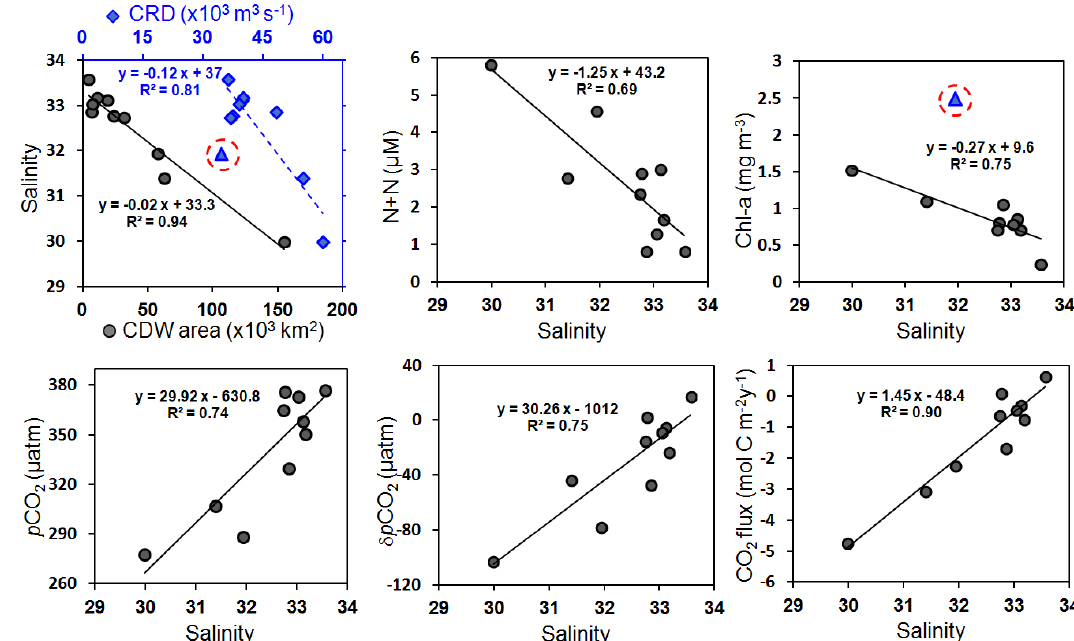
Figure 3. Relationships between areal mean SSS and hydrographic variables in the whole ECS. (*A triangle denotes the data obtained from the cruise of OR1-686 (19–26 June 2003). In the plot of Chl a vs. salinity, the circled triangle is an outlier that was not included in the regression analysis. The outlier was probably caused by the Typhoon Soudelor (16–18 June 2003) that passed over the eastern ECS shelf right before the cruise. The anomalously low salinity was probably caused by the typhoon rain instead of the river discharge, while the high Chl a level was probably caused by typhoon-driven vertical mixing rather than river discharged nutrients.